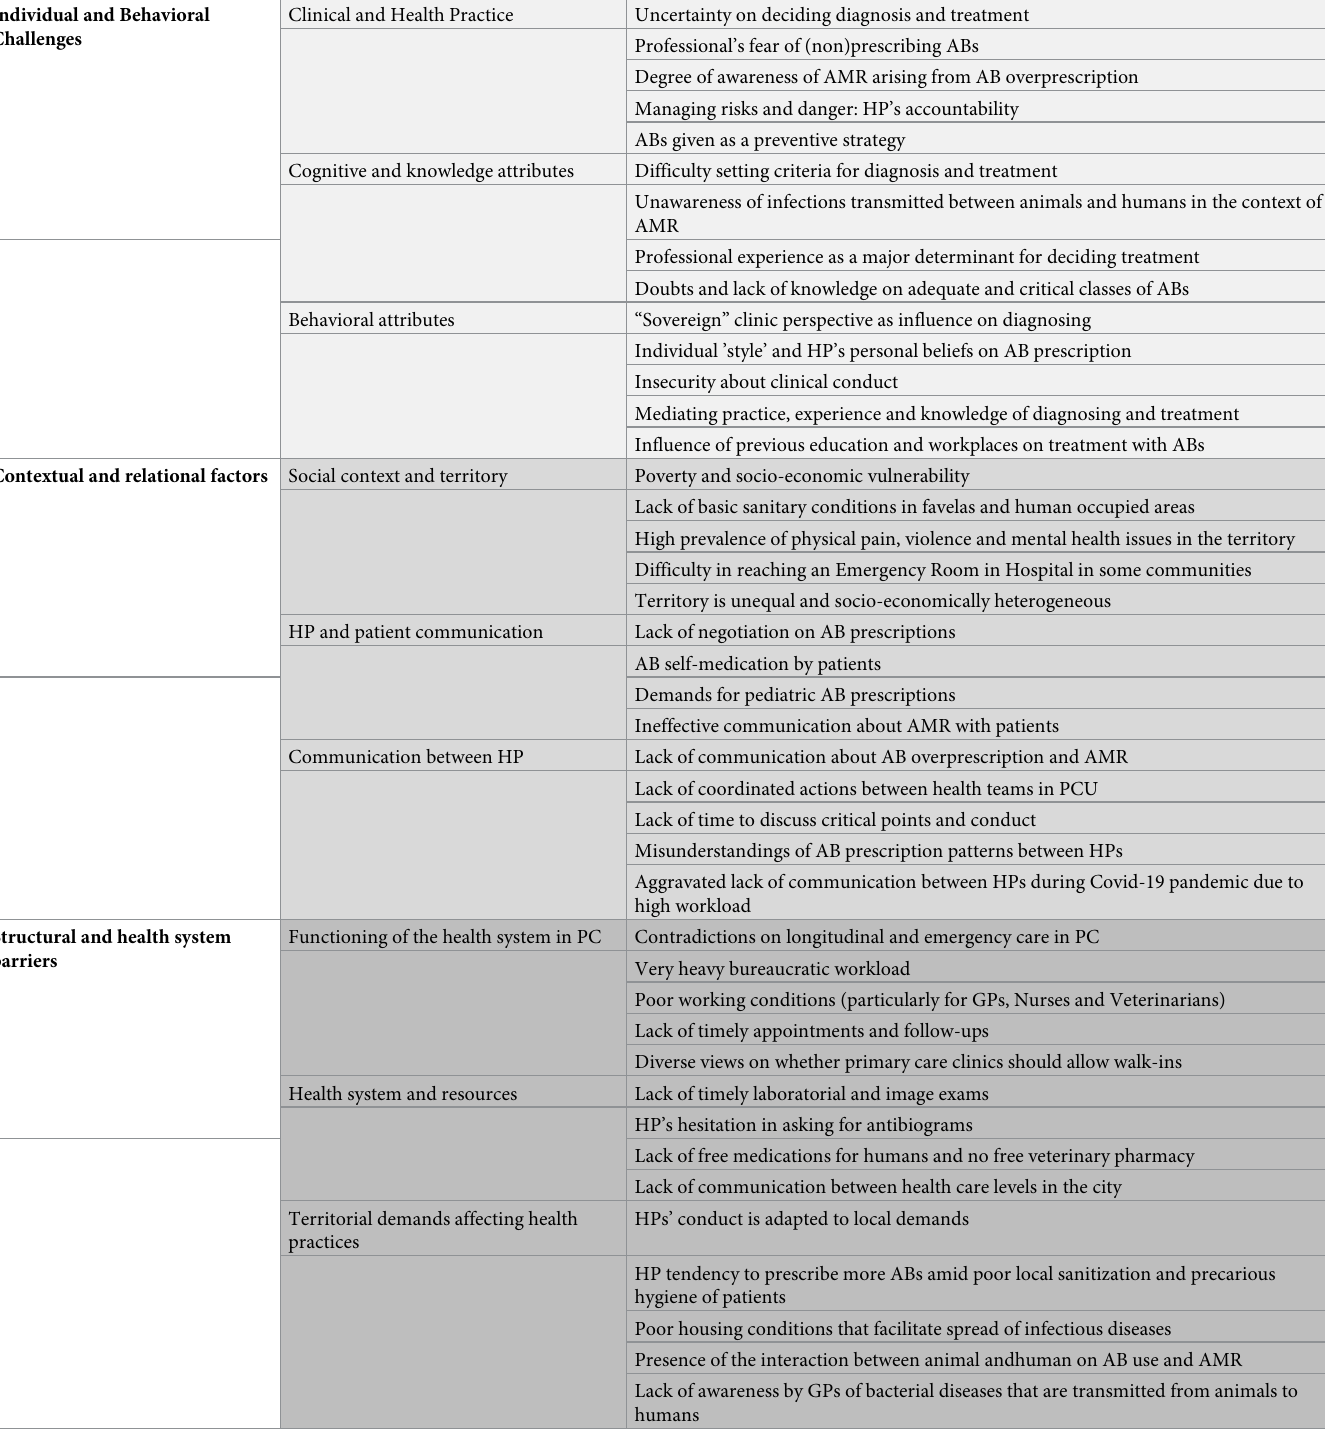
Table 1. Themes and subthemes stemming from the analysis of the interviews. Individual and Behavioral